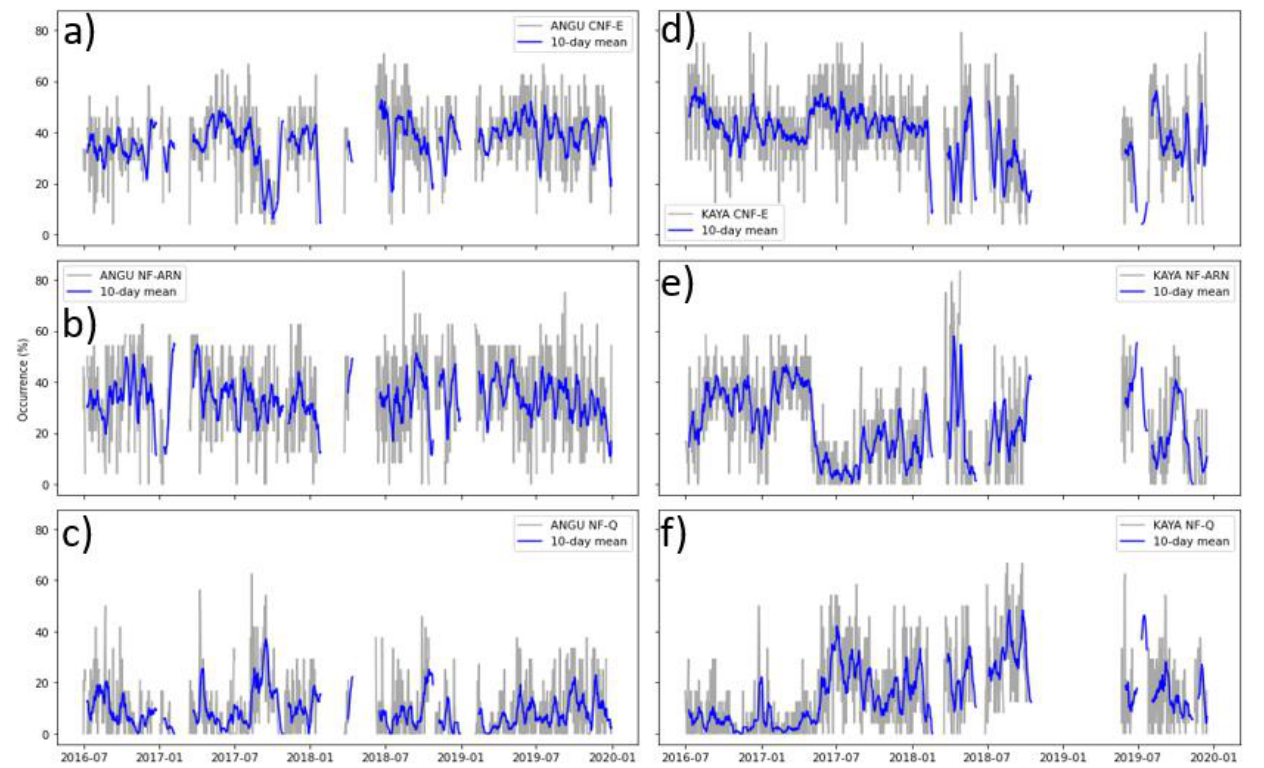
Figure 7. Hourly timeseries of C+NF feature occurrences (gray), with 10-day rolling mean (blue) over the period of 1 July 2016 through 31 December 2019. Daytime feature (CNF-E) is shown for ANGU ( a ) and KAYA ( d ), nighttime feature (NF-ARN) is shown for ANGU ( b ) and KAYA ( e ), and no-feature feature (NF-Q) is shown for ANGU ( c ) and KAYA ( f ).